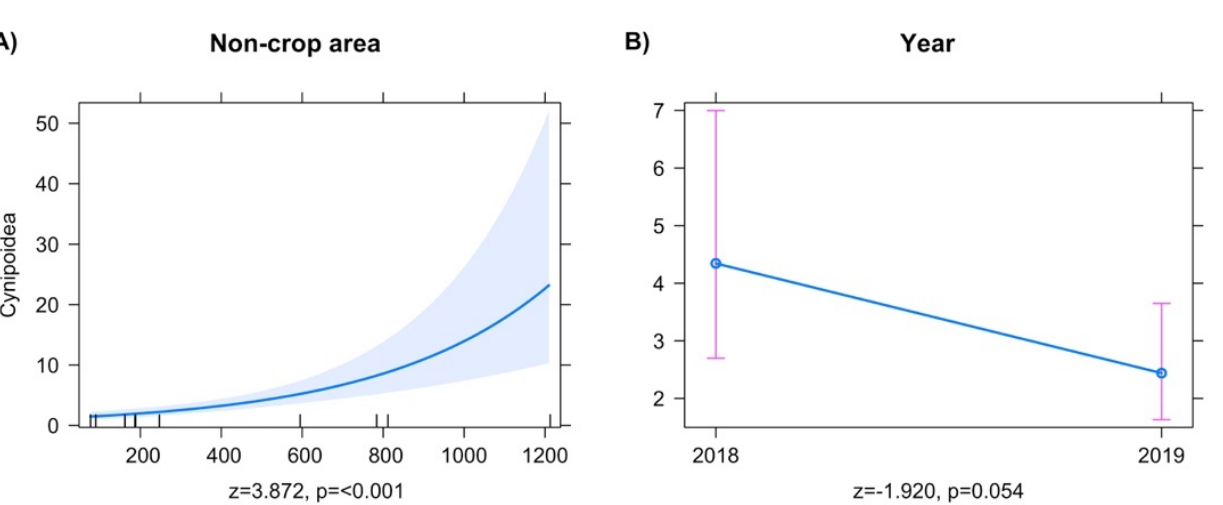
Figure 3. Predictor effect plots for individual explanatory variables on the abundance of superfamily Cynipoidea.